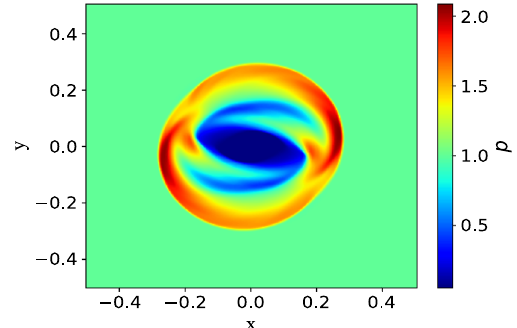
Fig. 10 The pressure of the fluid at t = 0 . 3 is displayed in the 2D resistive rotor test in the Cartesian coordinates